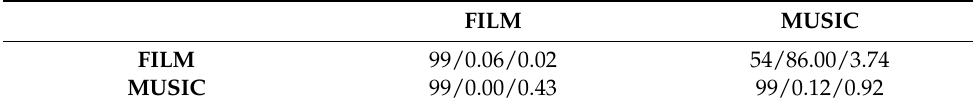
Table 6. ACC, FAR and FRR for the 2nd SVM classifier (%).